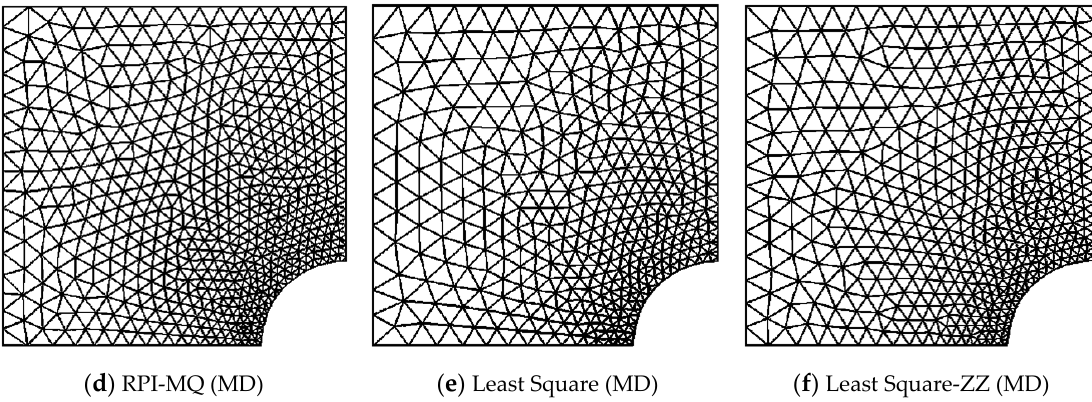
Figure 6. Adaptively improved mesh in elastic plate with opening using mesh free (MF) RPI having different node zone shape and least square error recovery analysis (initial triangular mesh elements = 548, 2% target error).